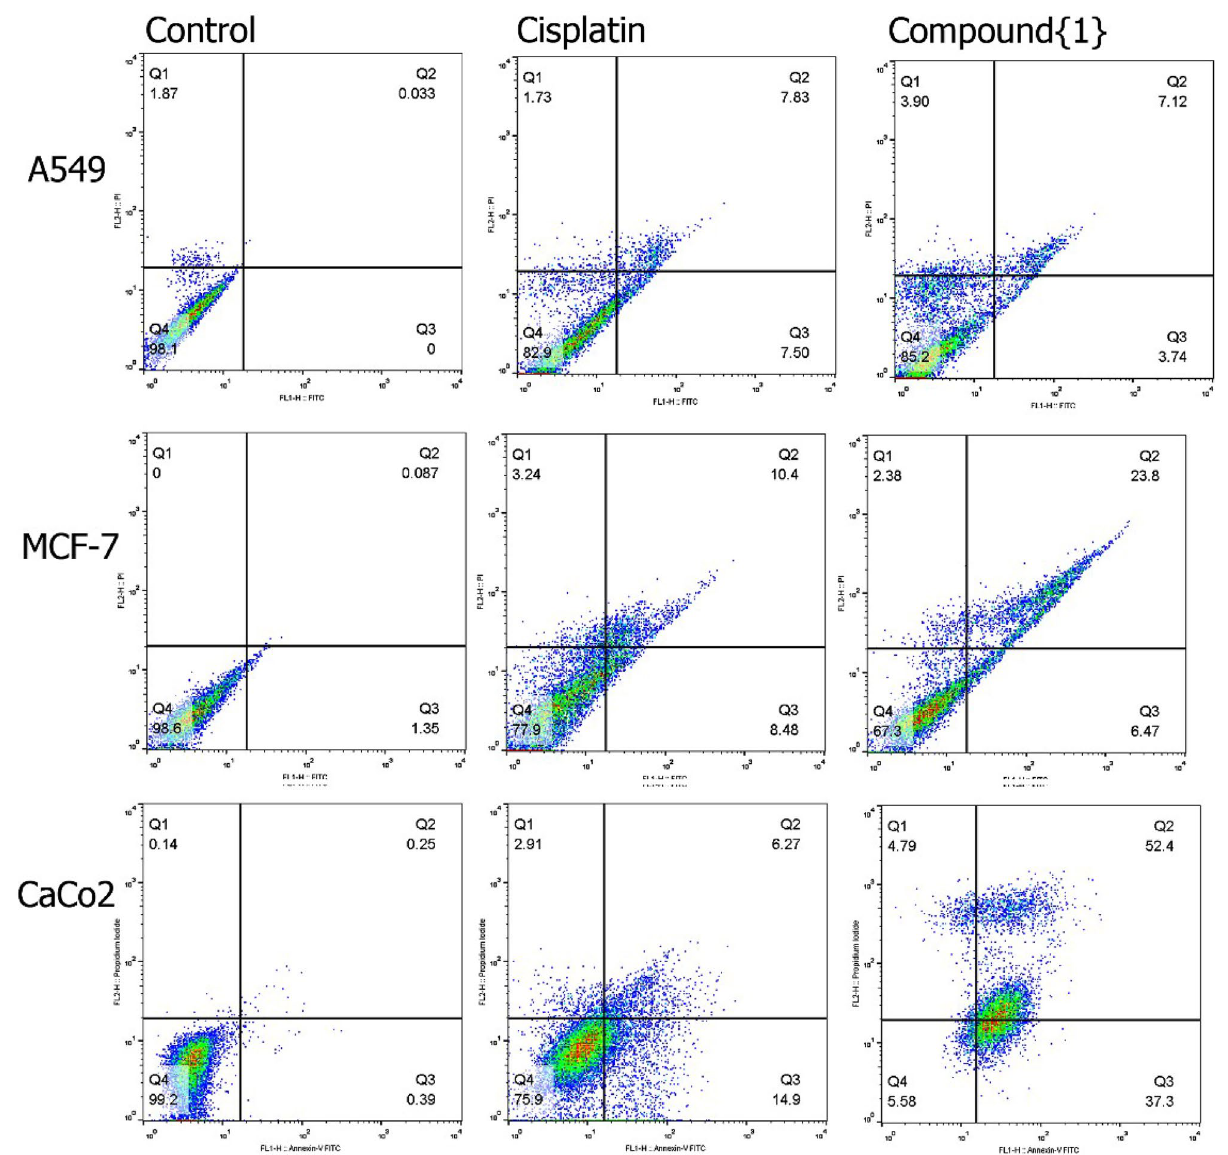
Figure 4. The apoptotic effects of treatments composed of cisplatin and Pt(TSC)Cl complex in A549, MCF-7 and Caco-2 cells were determined by flow cytometry. Untreated cells were considered as